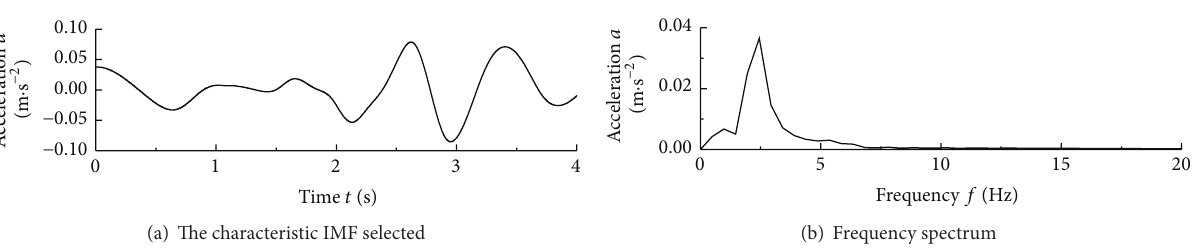
Figure 22: Analysis results of the signal presented in Figure 20 by EEMD: (a) the characteristic IMF and (b) FFT spectrum.